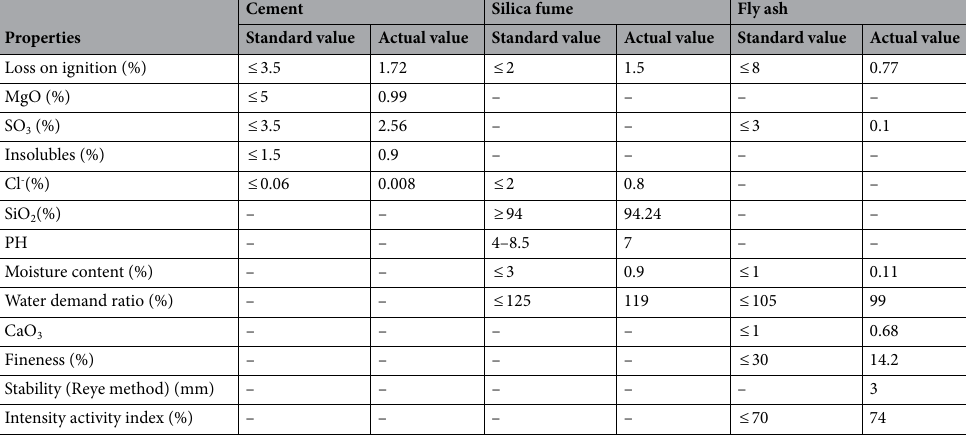
Table 1. The properties of cement, silica fume and fly